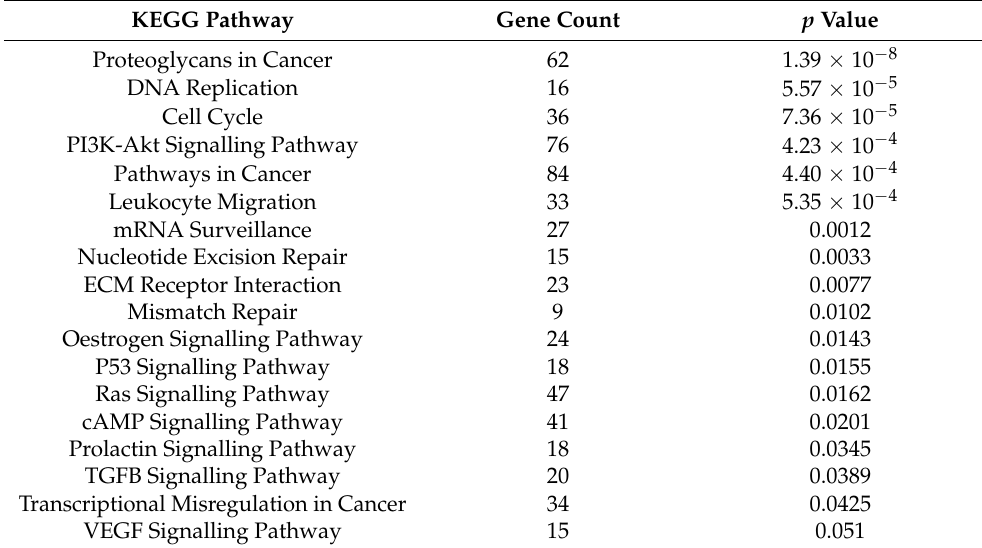
Table 1. Pathway enrichment analysis of upregulated genes from RNAseq analysis of 12-week-old Mmtv-Ccl2 transgenic mouse mammary glands.